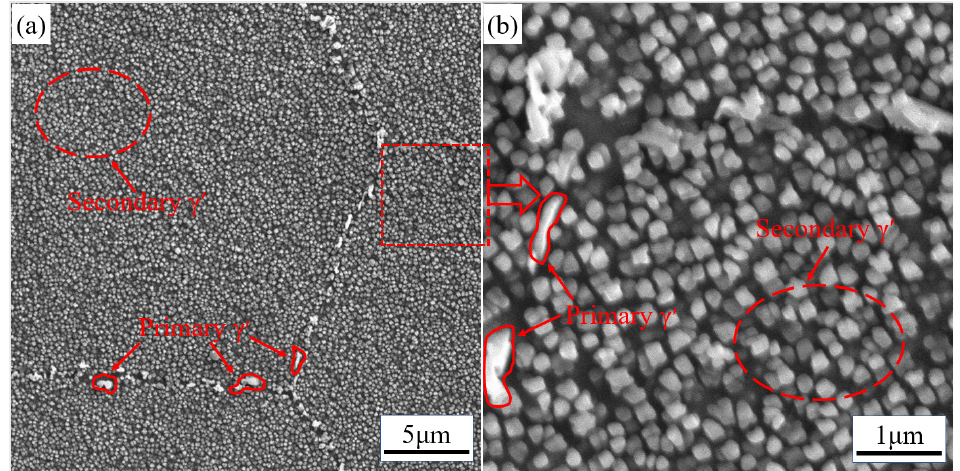
Figure 5. Morphology of γ′ precipitates after holding at 1100 °C for 1 h by AC: ( a ) low magnification, ( b ) high magnification and feature distribution of primary γ′ precipitates and secondary γ′ precipi- tates.